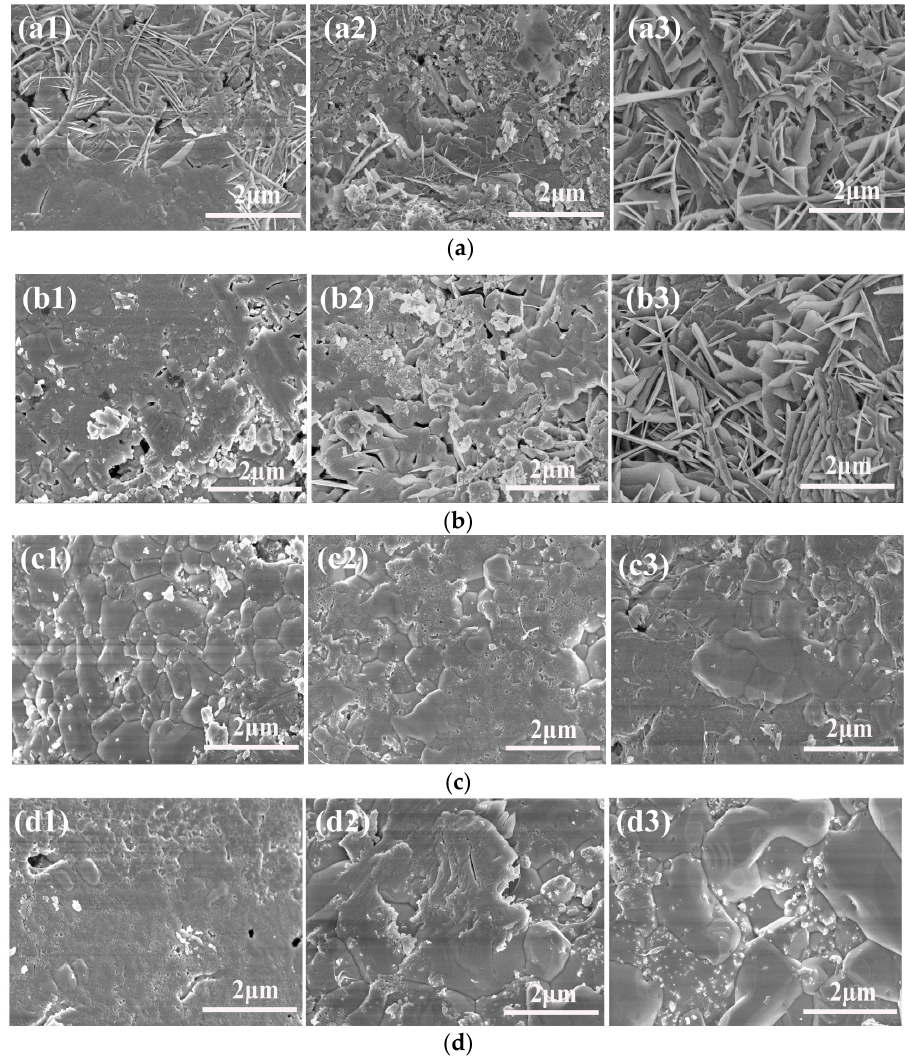
Figure 3. The surface morphologies of Bi 2 O 3 coatings: ( a1 ) BC ‐ 673 ‐ 2; ( a2 ) BC ‐ 673 ‐ 5; ( a3 )BC ‐ 673 ‐ 10; ( b1 ) BC ‐ 773 ‐ 2; ( b2 ) BC ‐ 773 ‐ 5; ( b3 ) BC ‐ 773 ‐ 10; ( c1 ) BC ‐ 873 ‐ 2; ( c2 ) BC ‐ 873 ‐ 5; ( c3 ) BC ‐ 873 ‐ 10; ( d1 ) BC ‐ 973 ‐ 2; ( d2 ) BC ‐ 973 ‐ 5; ( d3 ) BC ‐ 973 ‐ 10.